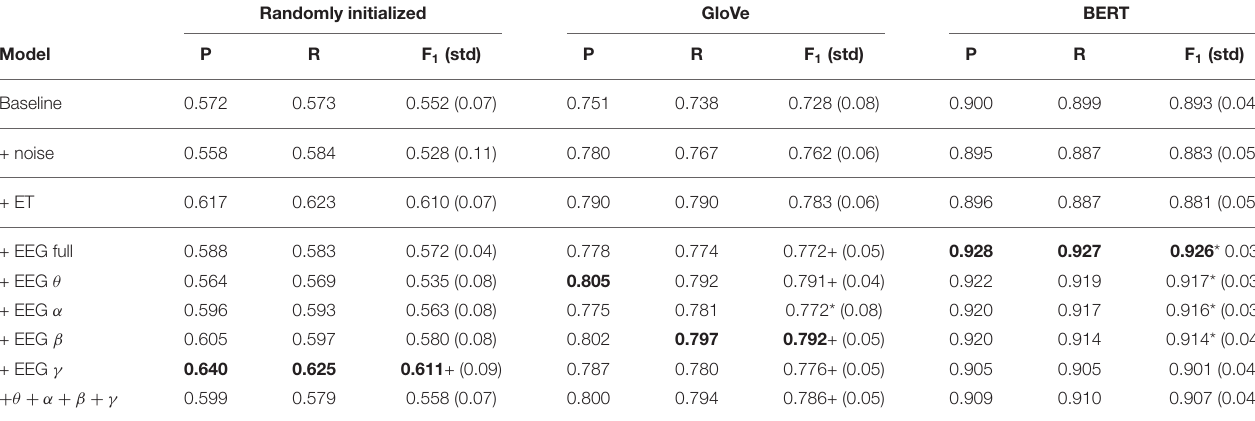
TABLE 7 | Binary sentiment analysis results of the multi-modal model using the convolutional EEG decoding component . Randomly initialized GloVe